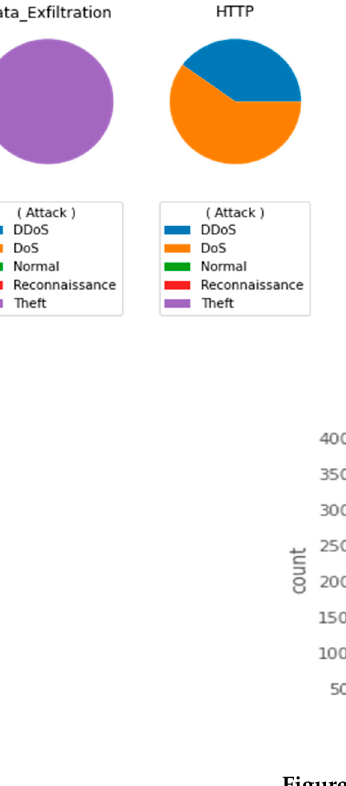
Figure 9. The main categories of attacks are found in the IoTID20 dataset.